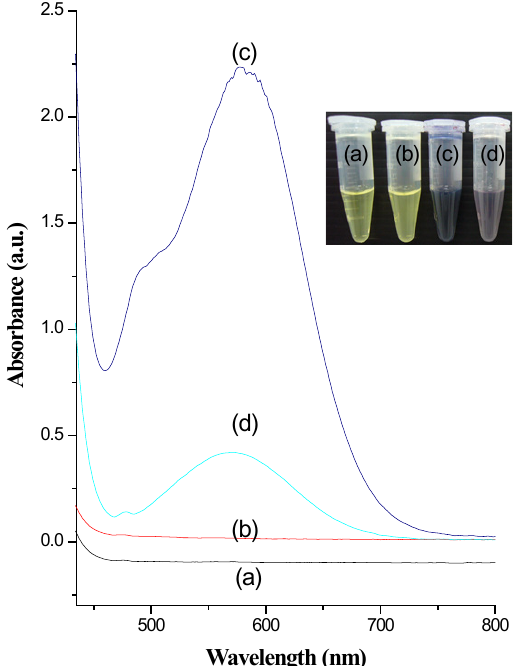
Figure 5. Ultraviolet–visible (UV-Vis) spectra and white-light sample images (inset) of ( a ) ninhydrin alone, ( b ) IBN-4 nanoparticles after surfactant removal, ( c ) IBN-4 nanoparticles modified with APTS groups (IBN-4-NH 2 ) and ( d ) IBN-4 nanoparticles modified with glutaraldehyde groups